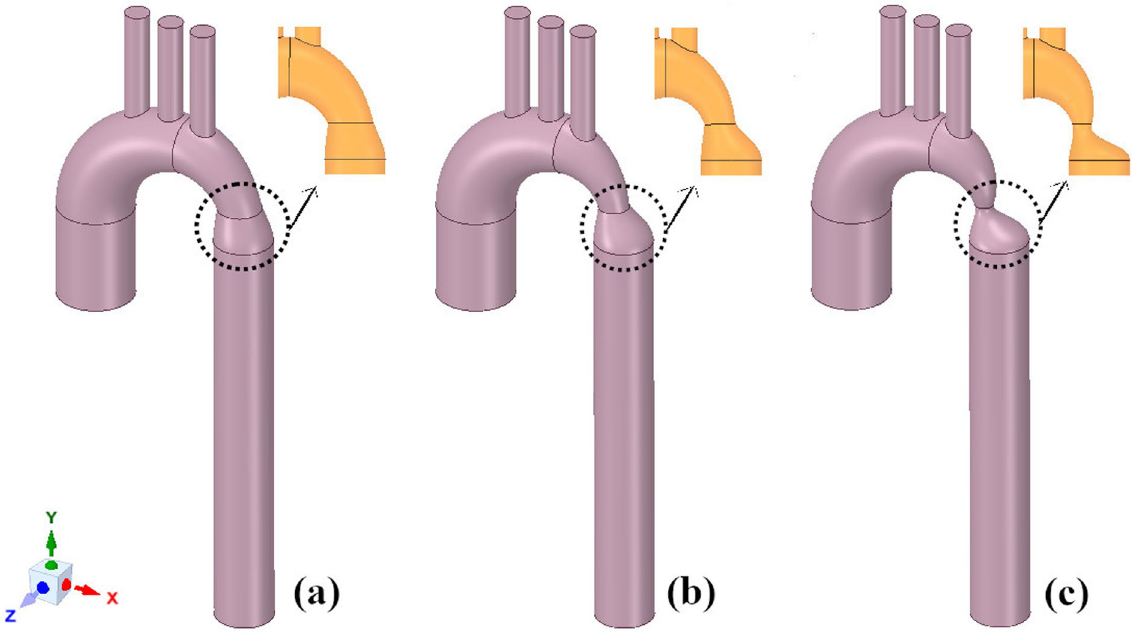
Figure 1. Three idealised geometries. ( a ) 25% coarctation; ( b ) 50% coarctation; and ( c ) 75%